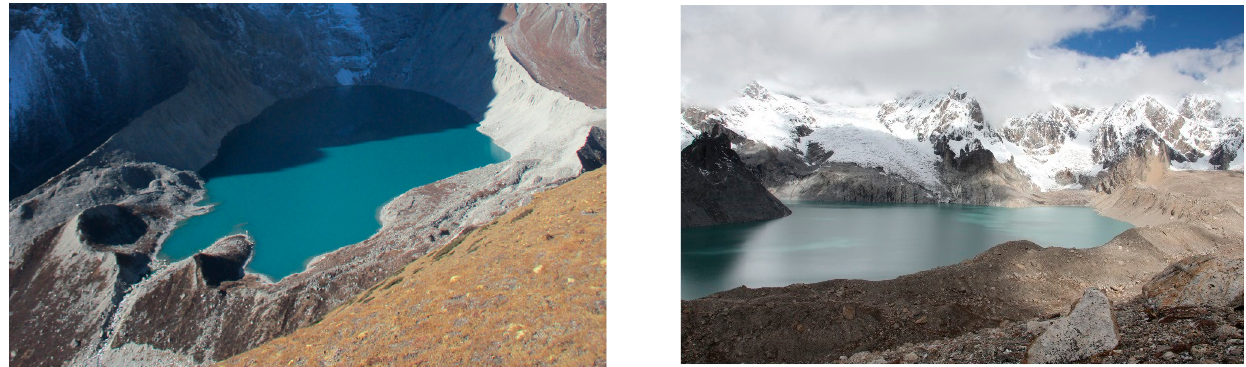
Figure 2. Jialong Co ( left , photo: T. Bolch) and Garlong Co ( right : photo: J.B. Pronk), moraine- dammed proglacial lakes located in the Poiqu River Basin.